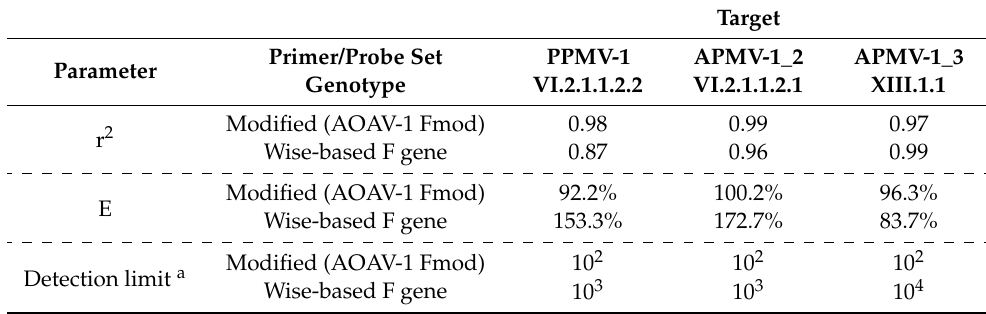
Table 3. Regression analysis of standard curves and sensitivity of the AOAV-1 F gene and the Wise-based F gene assay. r 2 : coefficient of determination; E: efficiency.